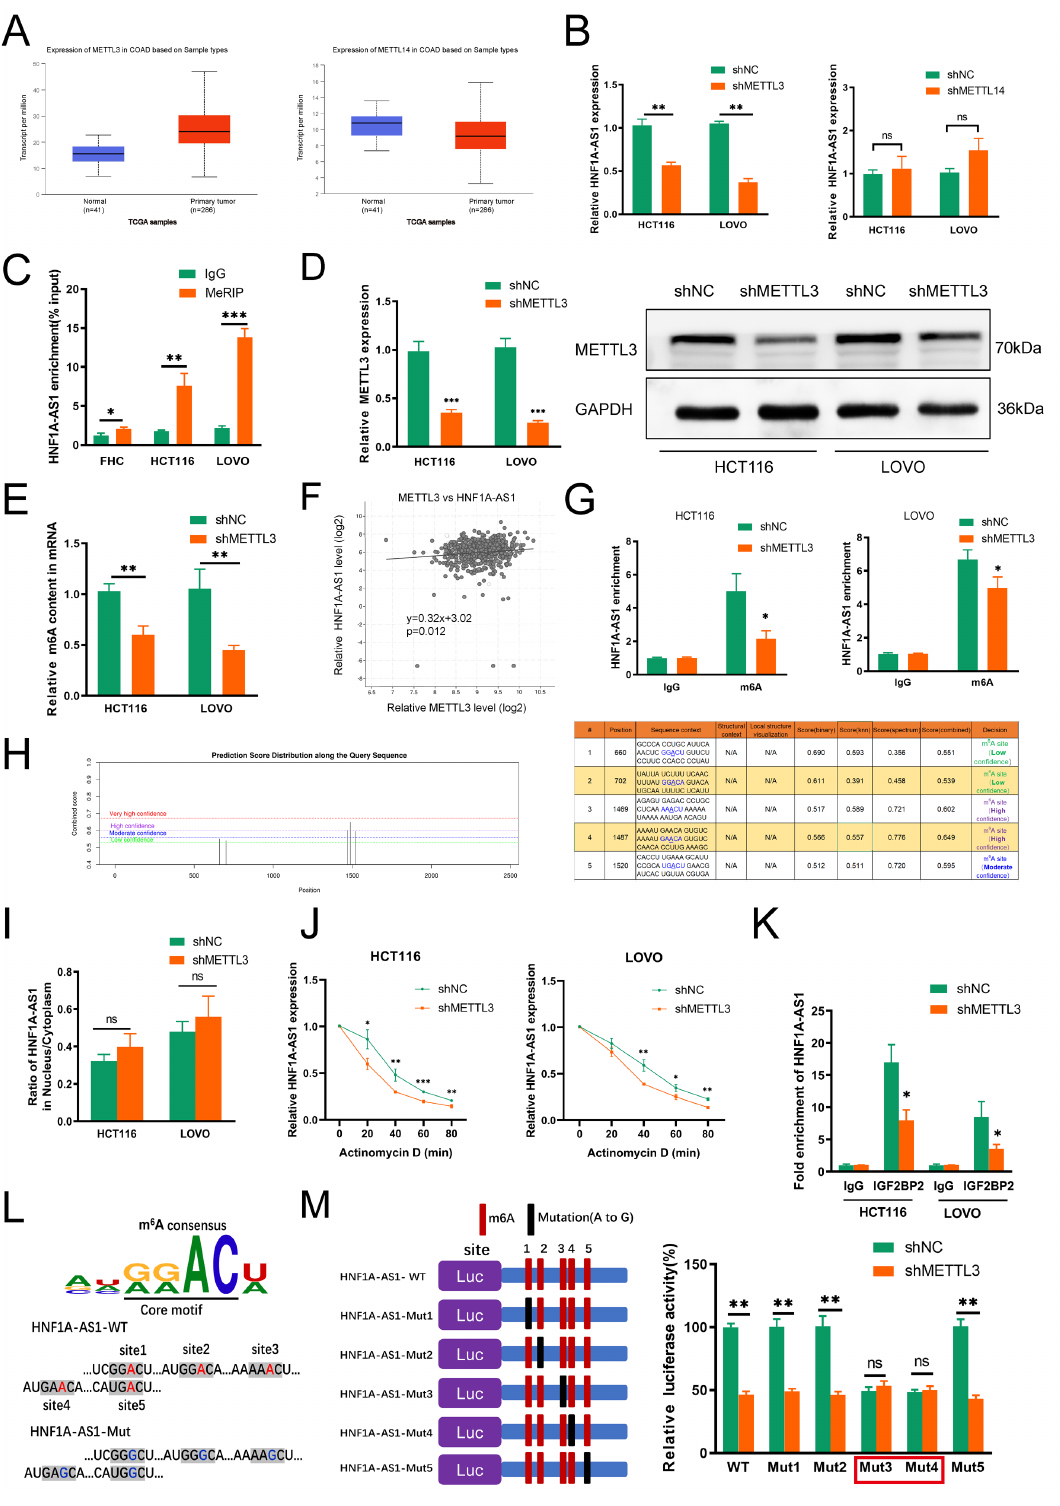
Figure 6. METTL3 induced HNF1A-AS1 m 6 A modification and upregulation in CRC. ( A ) The expression of METTL3 and METTL14 in colorectal cancer from TCGA database. ( B ) The